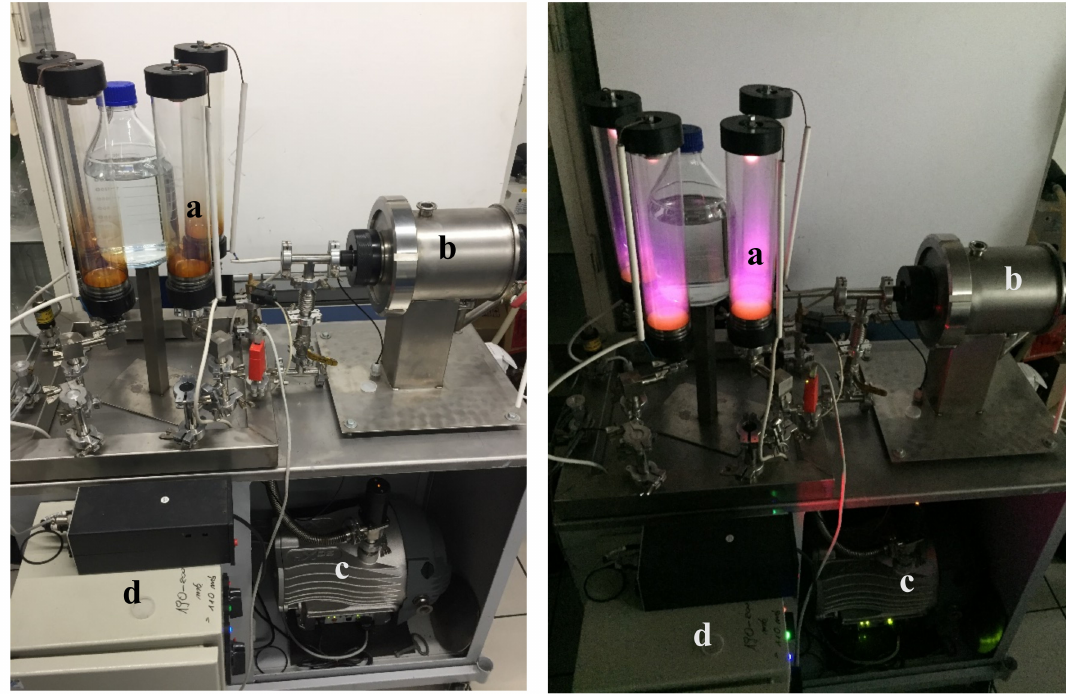
Figure 1. Plasmothrone (without cover) used in this study. ( a ) Lamps, ( b ) pulse generator, ( c ) vacuum pump, ( d ) power